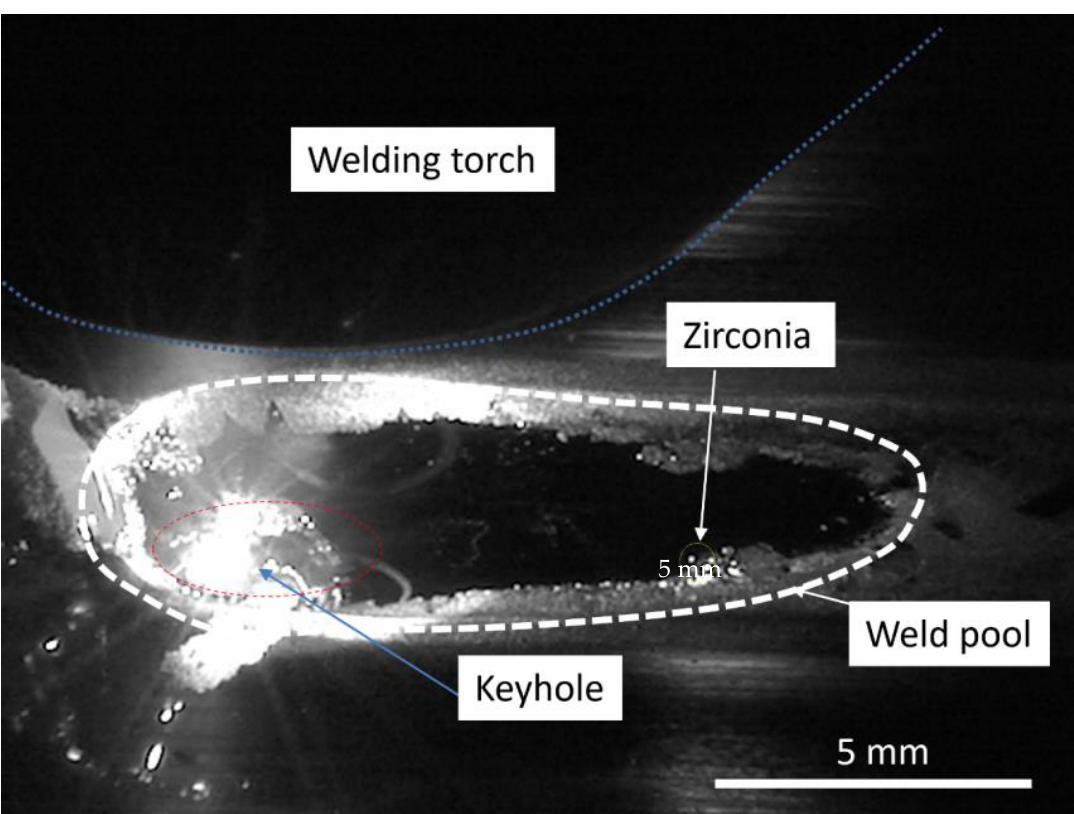
Figure 3. An example of the observation of the weld pool and molten material flow.